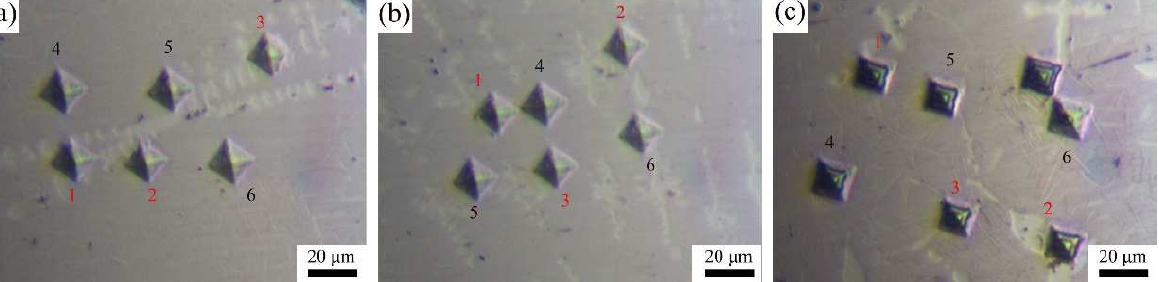
Figure 5. OM images of Vickers indentations prepared in the mixed zones containing BCC and Ti 2 AlNb (1–3) and the BCC zones (4–6): ( a ) Al 0.5 , ( b ) Al 1.0 and ( c ) Al 1.5 .